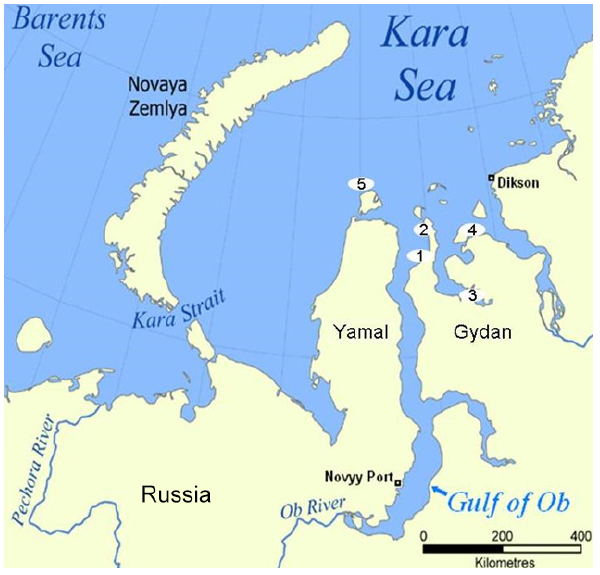
Figure 1. Regional distribution of the study sites in the Gydan peninsula: 1 – Haranasale Cape, 2 – Yavay Cape, 3 – Gyda Yuribey Gulf, 4 – Enisey Gulf, 5 – Belyi